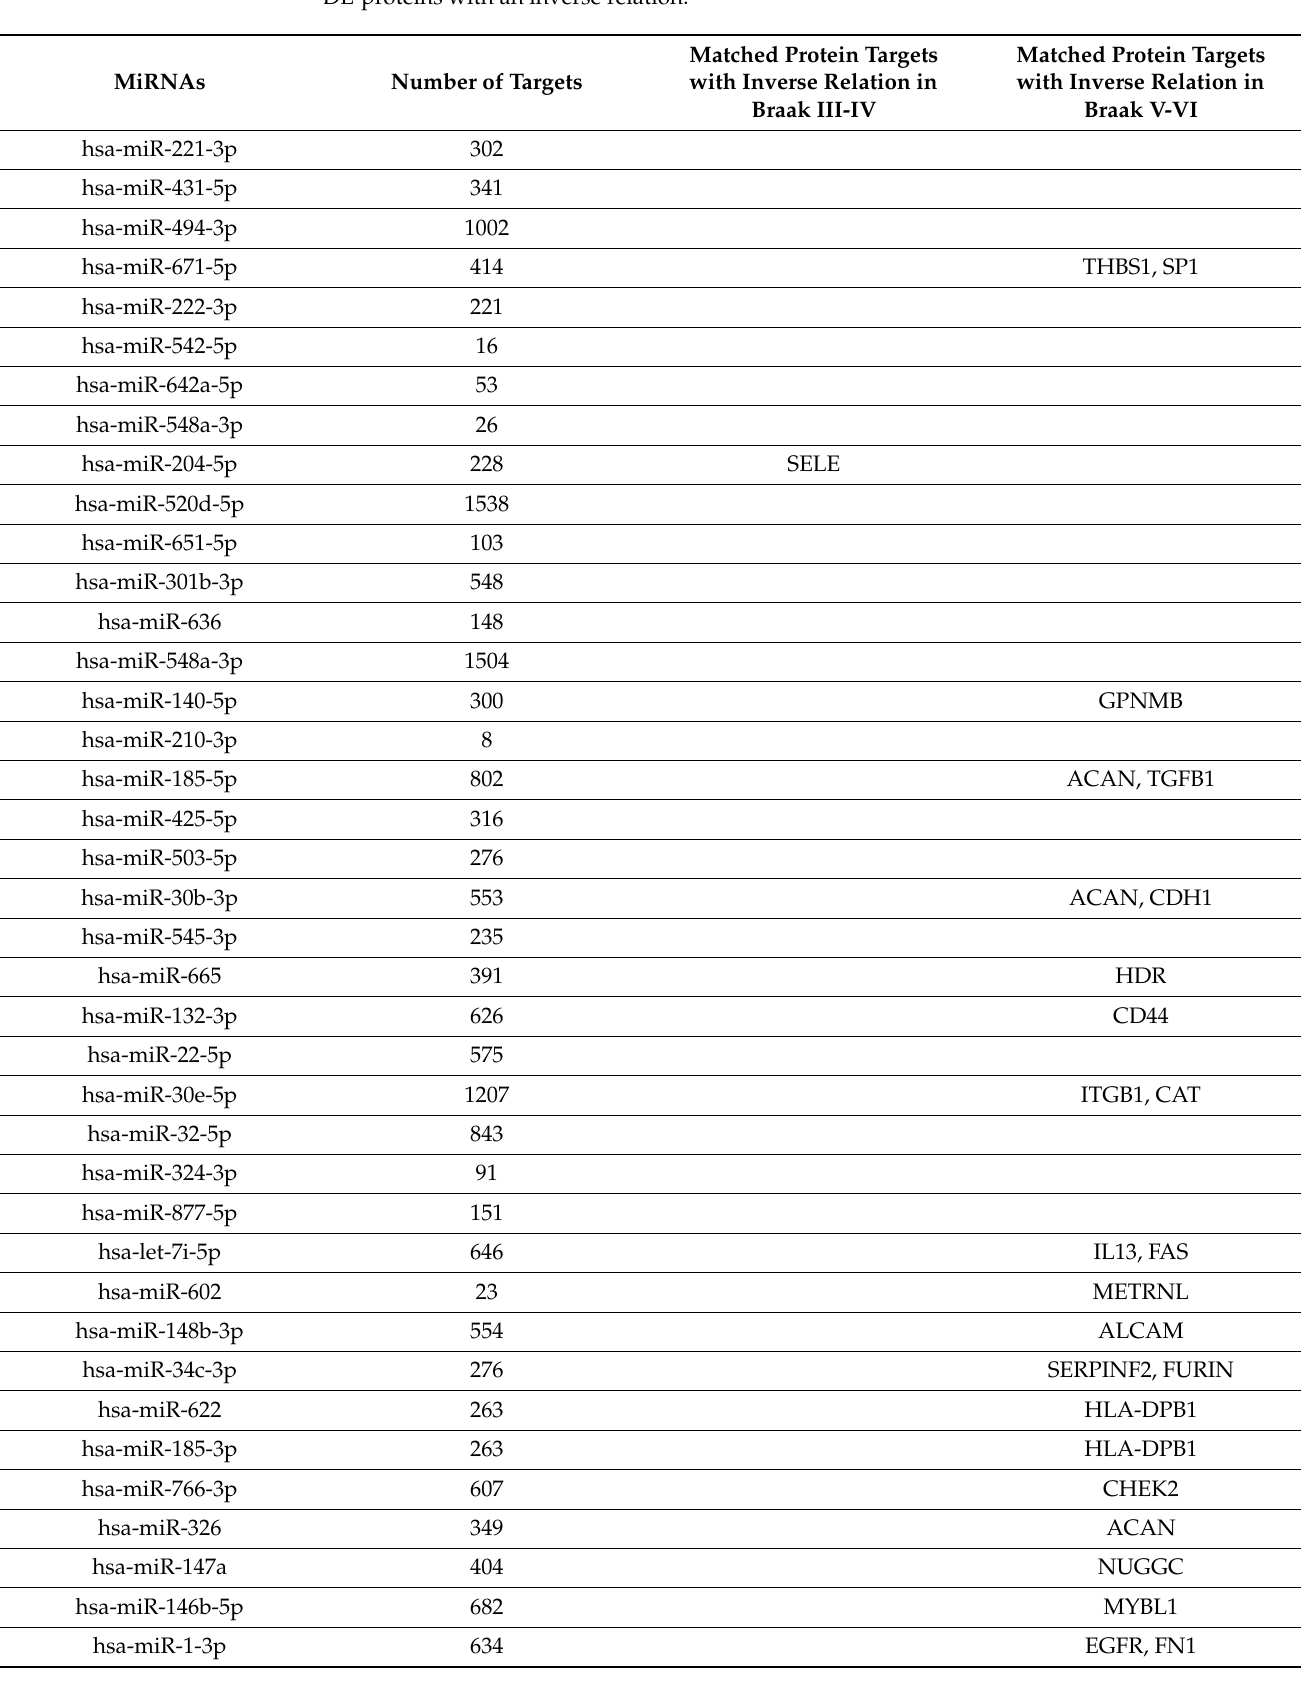
Table 4. Number of predicted targets for DE-miRNA in Braak III-IV and Braak V-VI and matched DE-proteins with an inverse relation. Matched Protein Targets Matched Protein Targets with Inverse Relation Number of Targets with Inverse Relation in